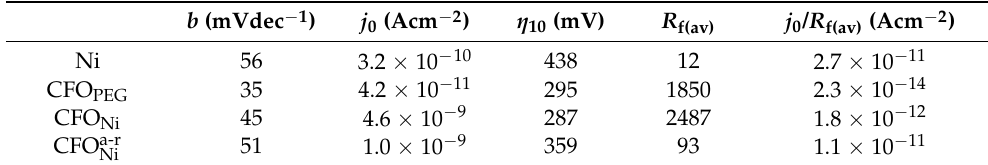
Figure 3. ( a ) polarisation curves, ( b ) Tafel plots and ( c ) chronopotentiometric curves obtained for CoFe 2 O 4 electrodes in 1 M KOH. Table 1. The Tafel slope b , the apparent exchange current density j 0 , the overpotential at a current density of 10 mAcm − 2 η 10 and the average roughness factor R f(av) obtained for CoFe 2 O 4 electrodes in 1 M KOH solution during